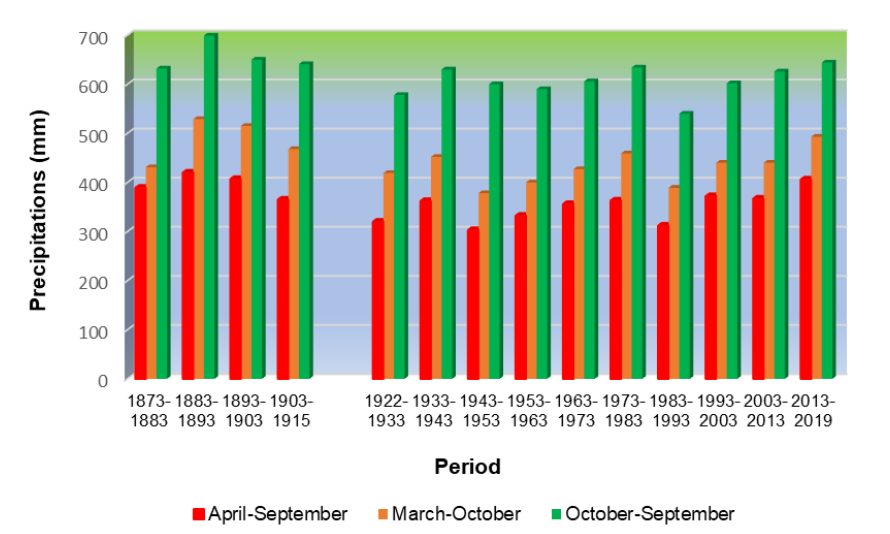
Figure 10. Dynamics of rainfall in the Banat Plain represented over periods of 10 years (1873 – 2019). If for the decade 1983 – 1993 there was the lowest average rainfall value for an agricultural year (540 mm), in the last two decades this value has increased slightly, while remaining at a low level (644 mm) compared to the first values recorded at the end of the 19th century. The highest values were recorded for the decade 1883 – 1893, which may also be explained by the conditions under which these measurements were made. The same trends were maintained for the conventional warm period